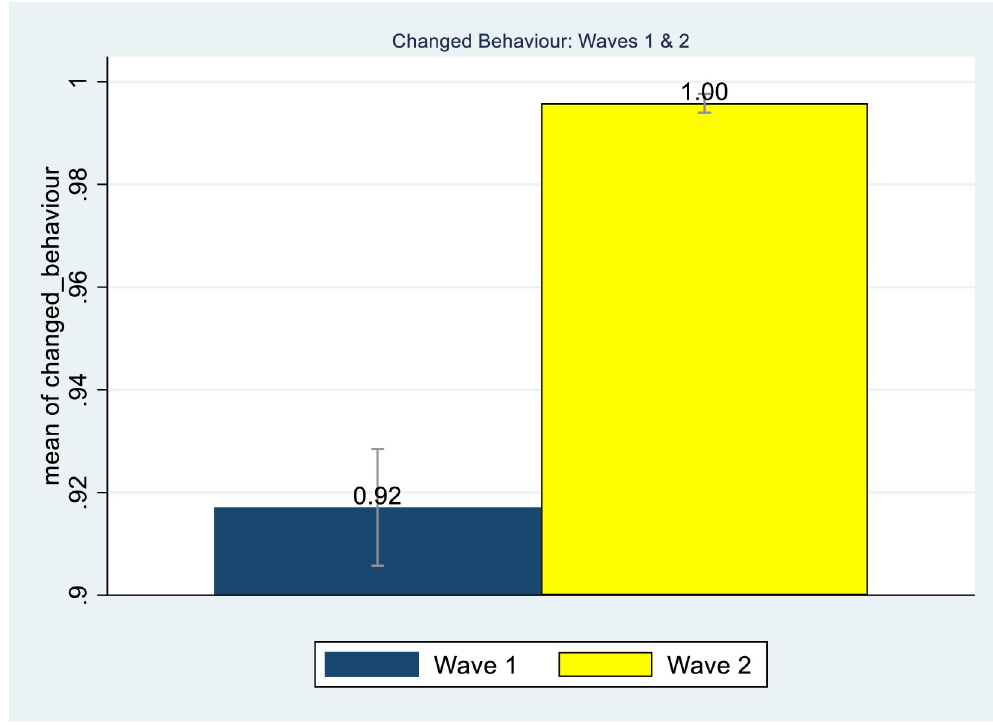
Fig 1. Behavioural change across Wave 1 and Wave 2. Source: NIDS-CRAM, Wave 1 (2020) and NIDS-CRAM, Wave 2 (2020). Data are weighted. The bars show the reported change in behaviour. 95% confidence intervals are shown.